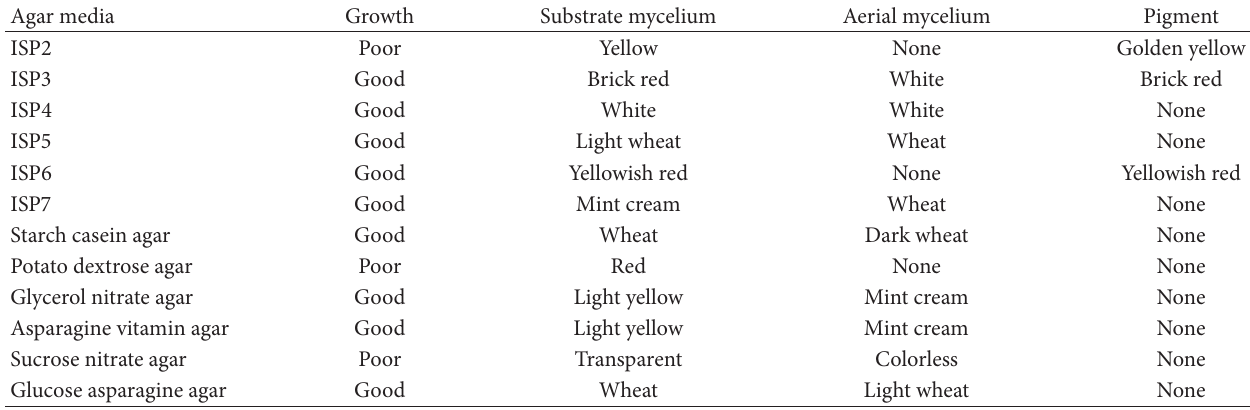
Table 1: Growth characteristics of strain